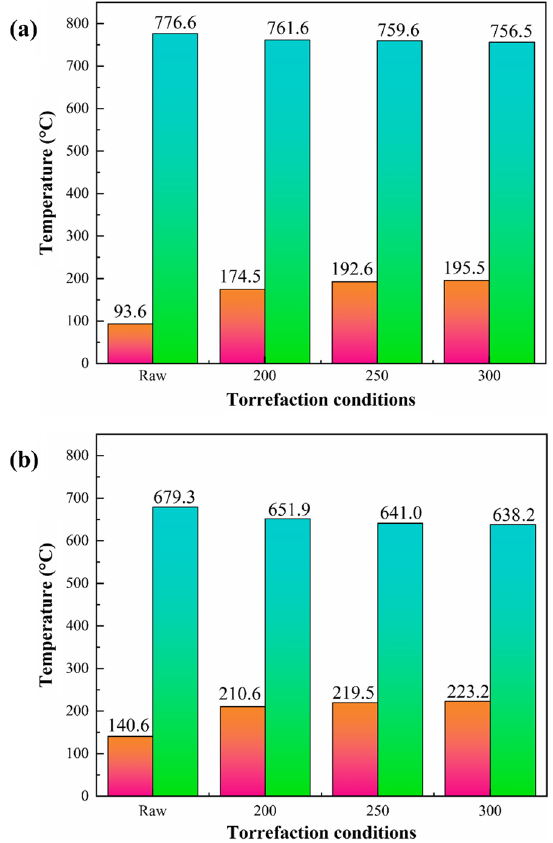
Fig. 7 a Initial and terminated pyrolysis temperatures and b ignition and burnout temperatures of raw and torrefied